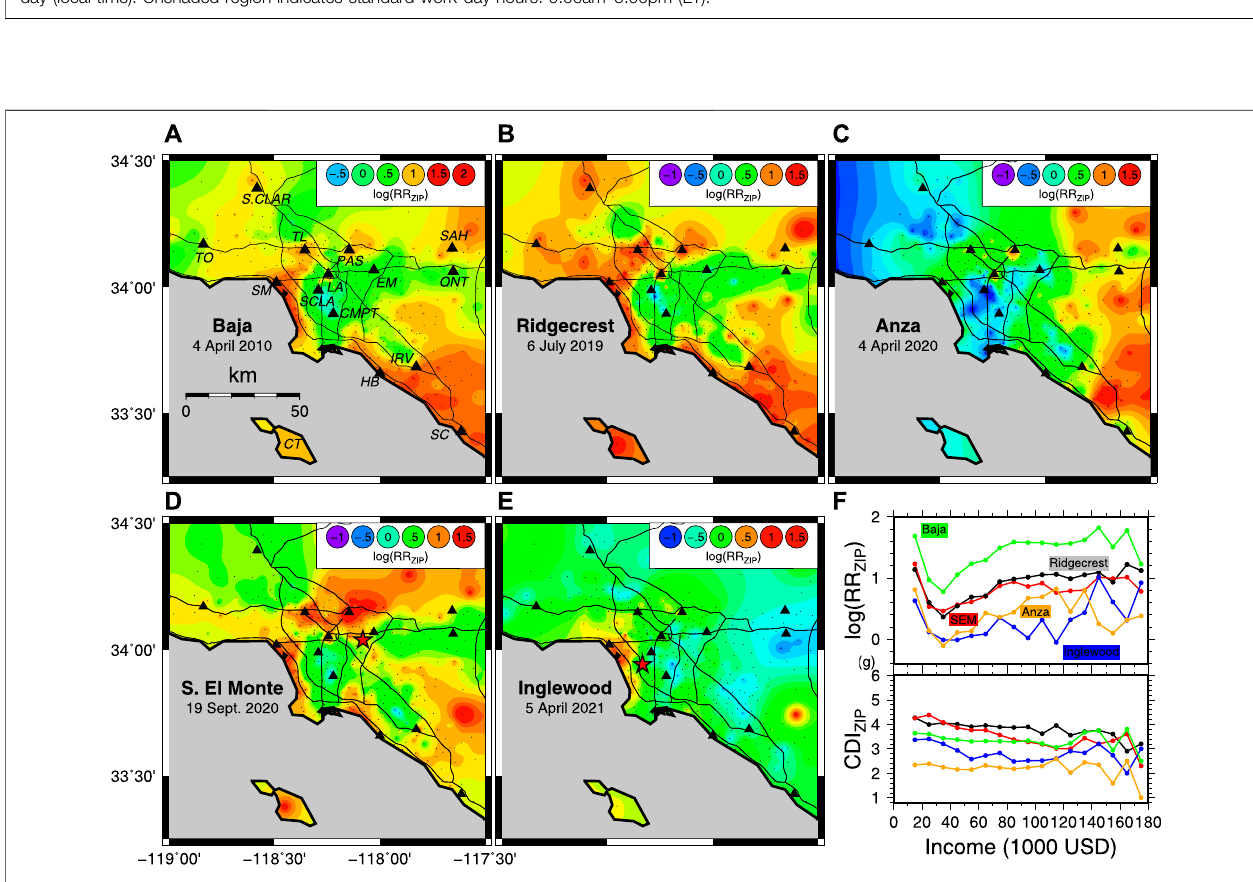
FIGURE 4 | (A, top left) Contoured normalized response rate (logarithmic scale) across the greater Los Angeles area for the 2011 M 7.2 Baja earthquake. Small blackdotsshowZIPcodecentroids;lightblacklinesin (A) – (E) indicatemajorhighways;trianglesindicatecities( LA :DowntownLosAngeles, PAS :Pasadena, SM :Santa Monica; TO :ThousandOaks; HB :HuntingtonBeach; SCLA : South-Central LosAngeles; SC : SanClemente; TL :Toluca Lake; S. CLAR :Santa Clara;S AH : San Antonio Heights). (B, top middle) similar plotfor 6 July 2019 M 7.1 Ridgecrestmainshock. In (B) – (D) thesamecolor scale is used, and triangles indicate locations of cities labeled in (A) ; (C, top right) similar plot for 2010 M 4.9 Anza earthquake; (D, bottom left) similar plot for 2020 M 4.5 South El Monte earthquake (red star indicates epicenter); (E,bottommiddle) similarplotfor2021 M 4.0Inglewoodearthquake(redstarindicatesepicenter;differentcolorscale,asindicated); (F,bottomright) .Top panel shows log-averaged binned RRZIP values versus household income for ZIP codes within map area shown in (A) – (E) . Results for individual events are plotted with different colors, as labeled; bottom panel shows bin-averaged CDIZIP values for same events, same color conventions.